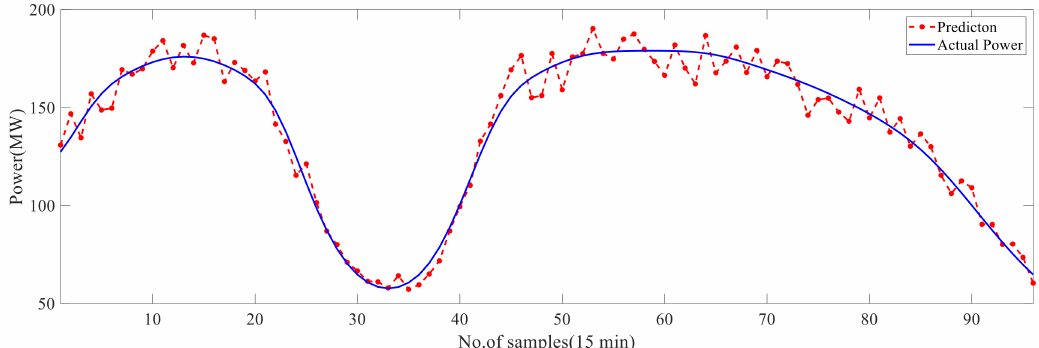
Figure 8. Actual and Forecasted output power of wind plant for a fall day. Table 1. Comparison of proposed model for wind prediction with other methods with rest to MAE. Forecasting Method